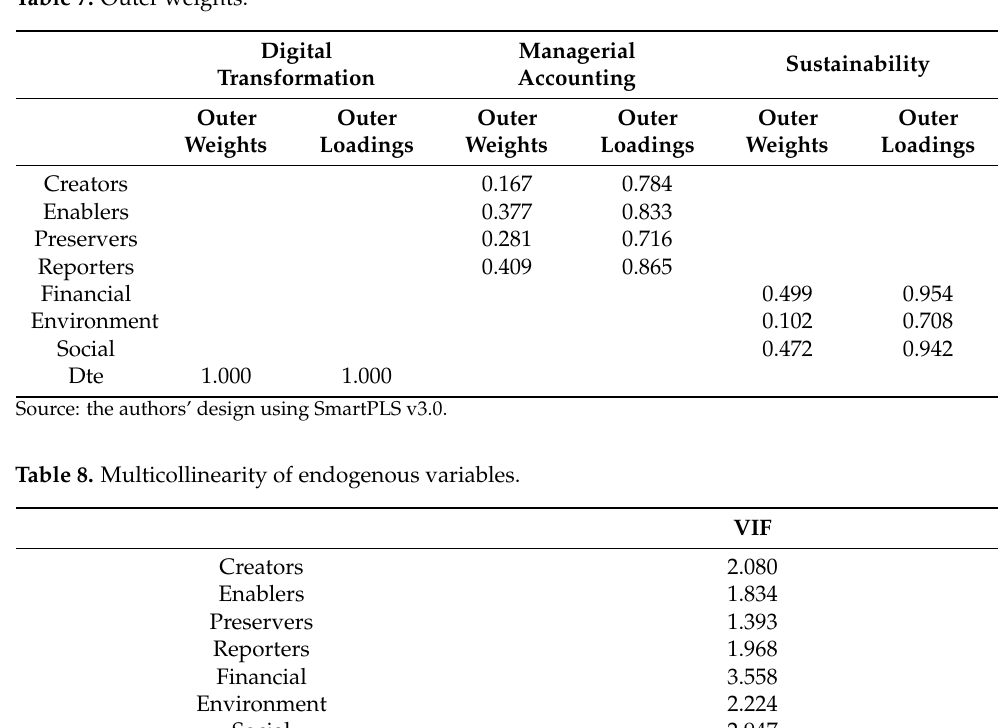
Table 7. Outer weights.